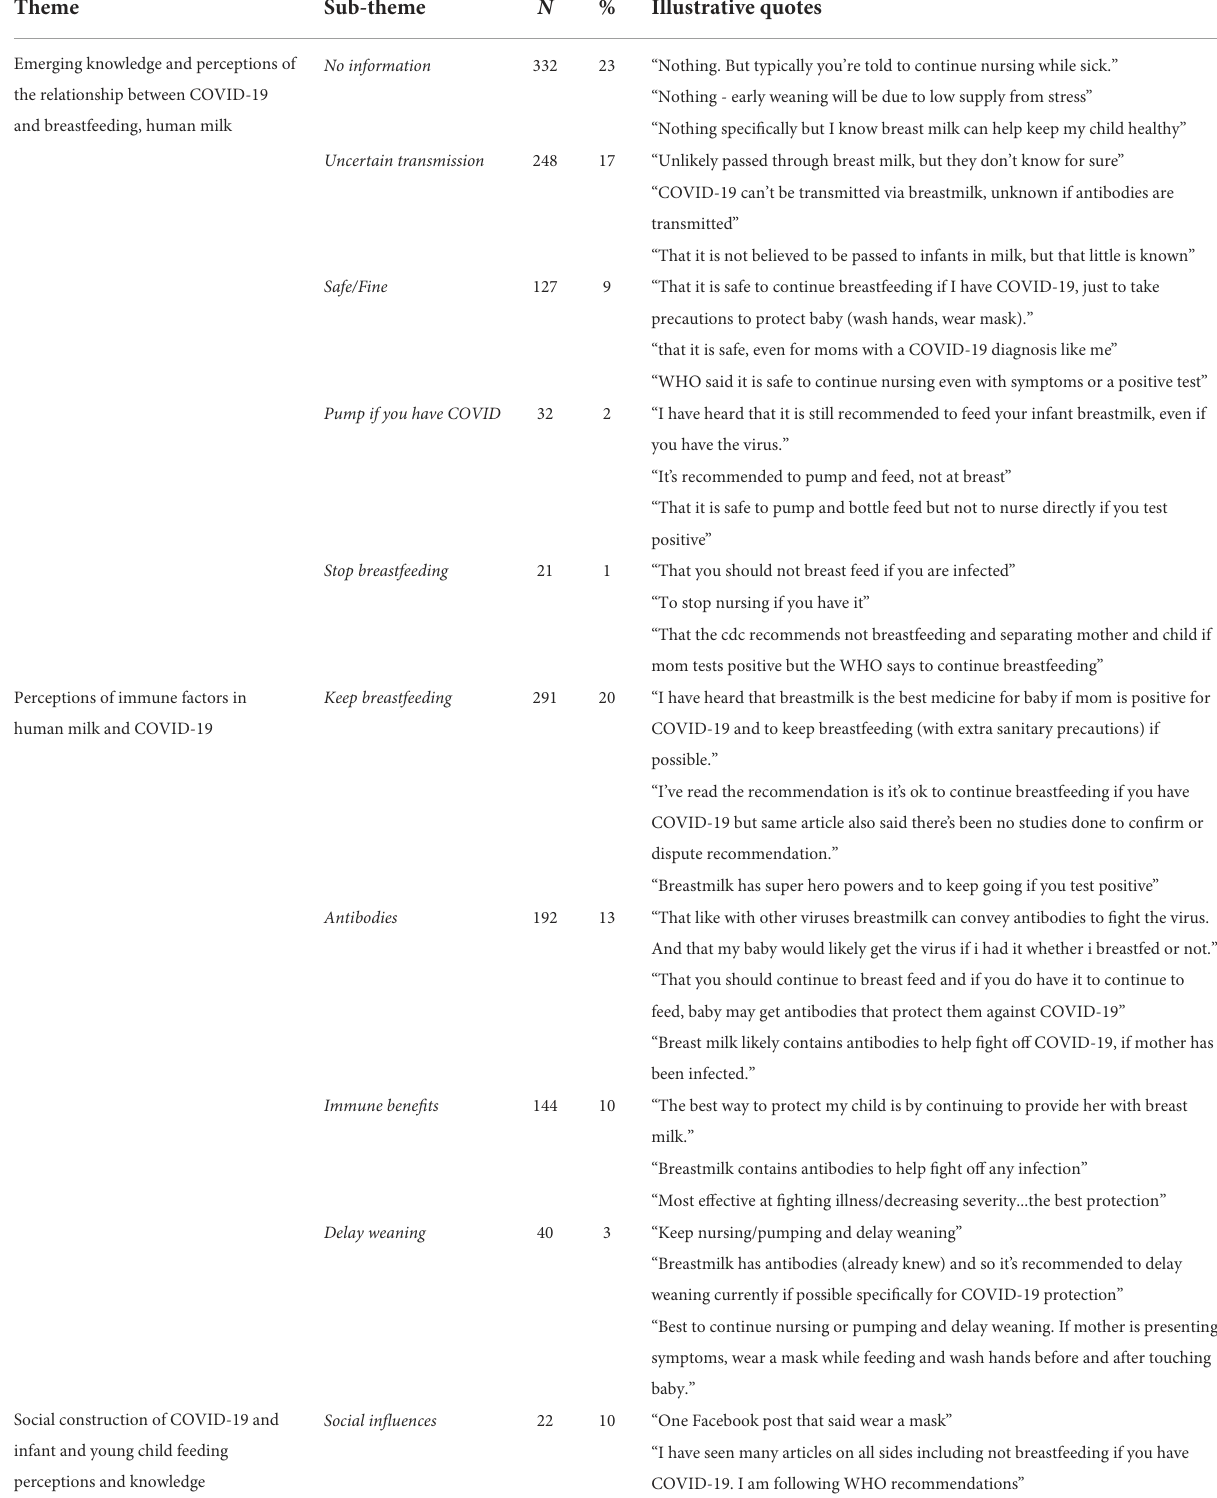
TABLE 5 Themes, sub-themes, and illustrative quotes from survey respondents, ages 18 years, and older currently feeding an infant or young child 2 years of age or younger, March–May 2020.